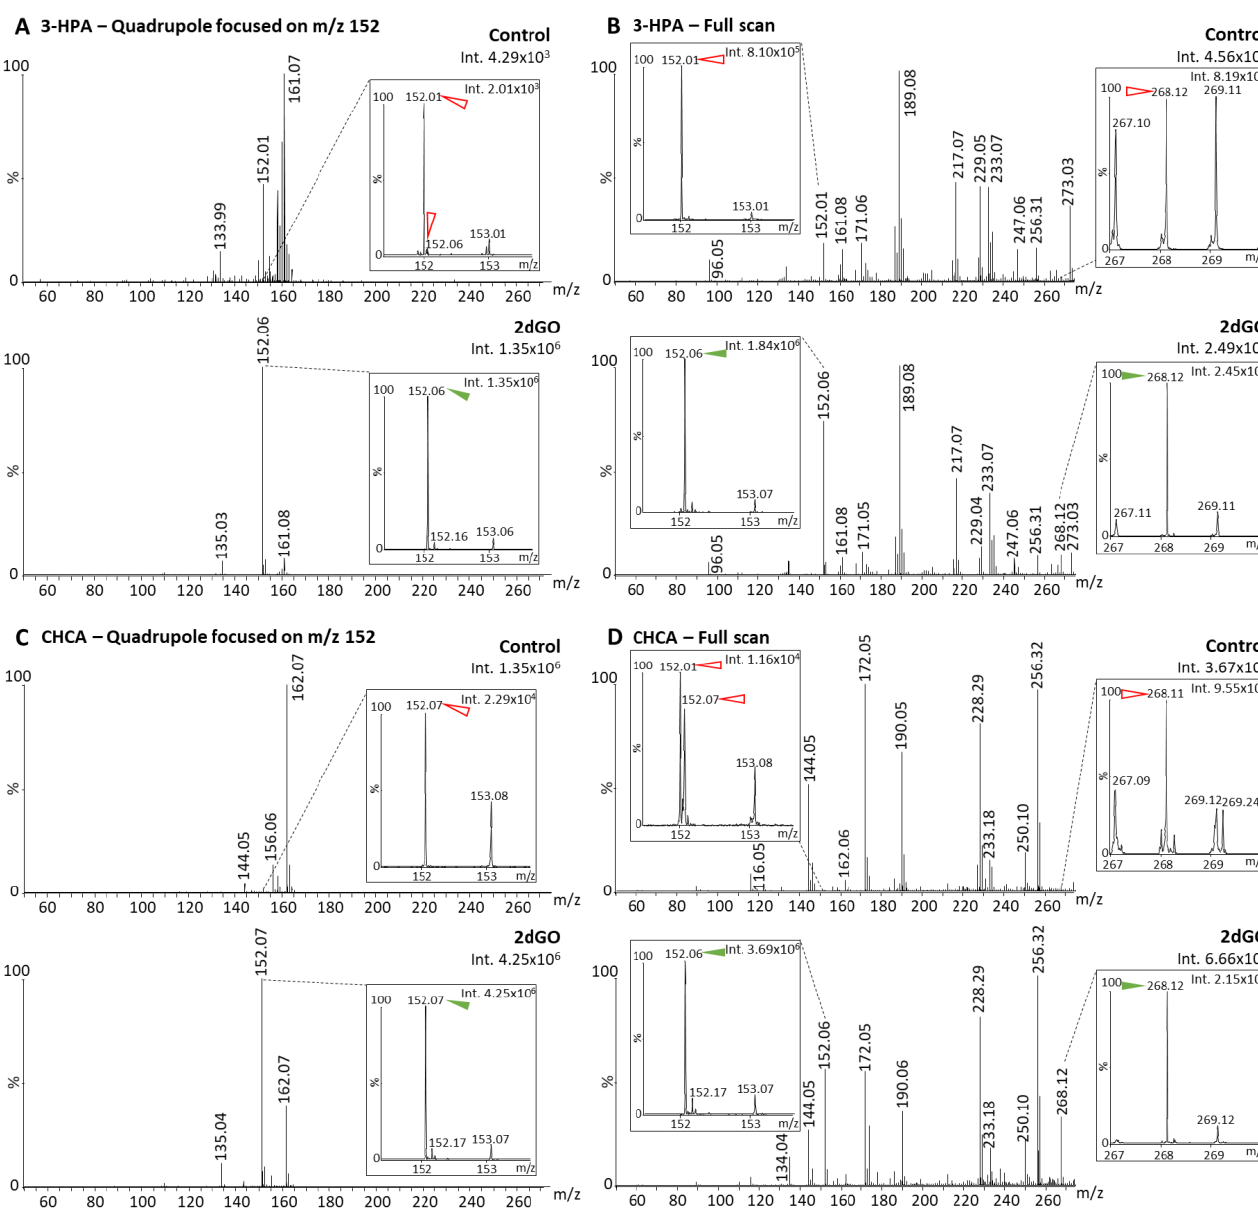
Figure 4. Matrix-assisted laser desorption/ionization (MALDI) mass spectra of solvent (control) and 2′ -deoxyguanosine (2dGO) stock solution at 0.5 µg/mL in MeOH/H 2 O 1:1 with zoomed views on the 2dGO parent peak at m/z 268.1 and its fragment peak at m/z 152.06. Spectra were obtained with 3-hydroxypicolinic acid (3-HPA) MALDI matrix with the quadrupole focused on the fragment mass m/z 152 ( A ) or in full scan ( B ), and with alpha-cyano-4-hydroxy-cinnamic acid (CHCA) MALDI matrix with the quadrupole focused on the fragment mass m/z 152 ( C ) or in full scan ( D ). Maximum intensities are given in arbitrary units (a.u.) on the top right corner of each spectrum and zoomed view. Peaks from the MALDI matrices are marked with red open arrows and peaks from 2dGO with green solid arrows.